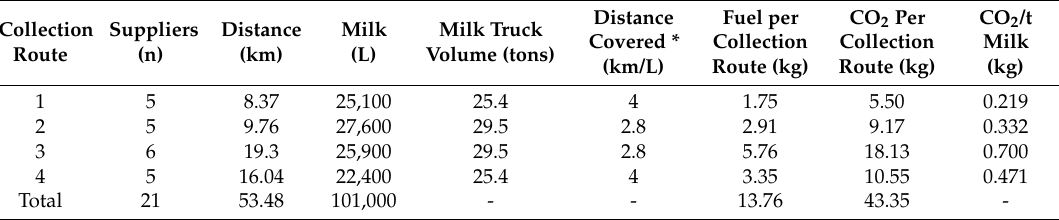
Table 4. Distance (km) and CO 2 emissions (kg) of milk collection routes in the ex-ante phase with a simulation of 21 suppliers.